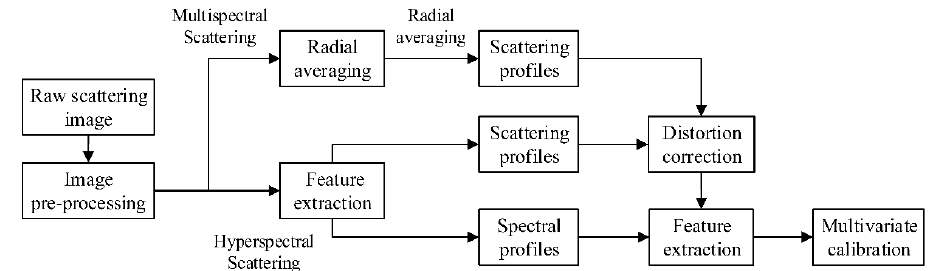
Figure 9. Procedures for analyzing multispectral and hyperspectral scattering images.